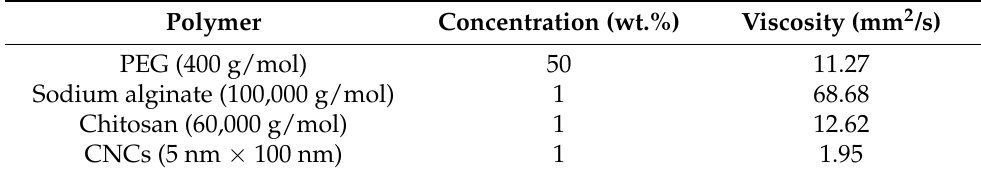
Table 1. Measured viscosity of the polymers used in this work, all measurements recorded at 25 ◦ C.